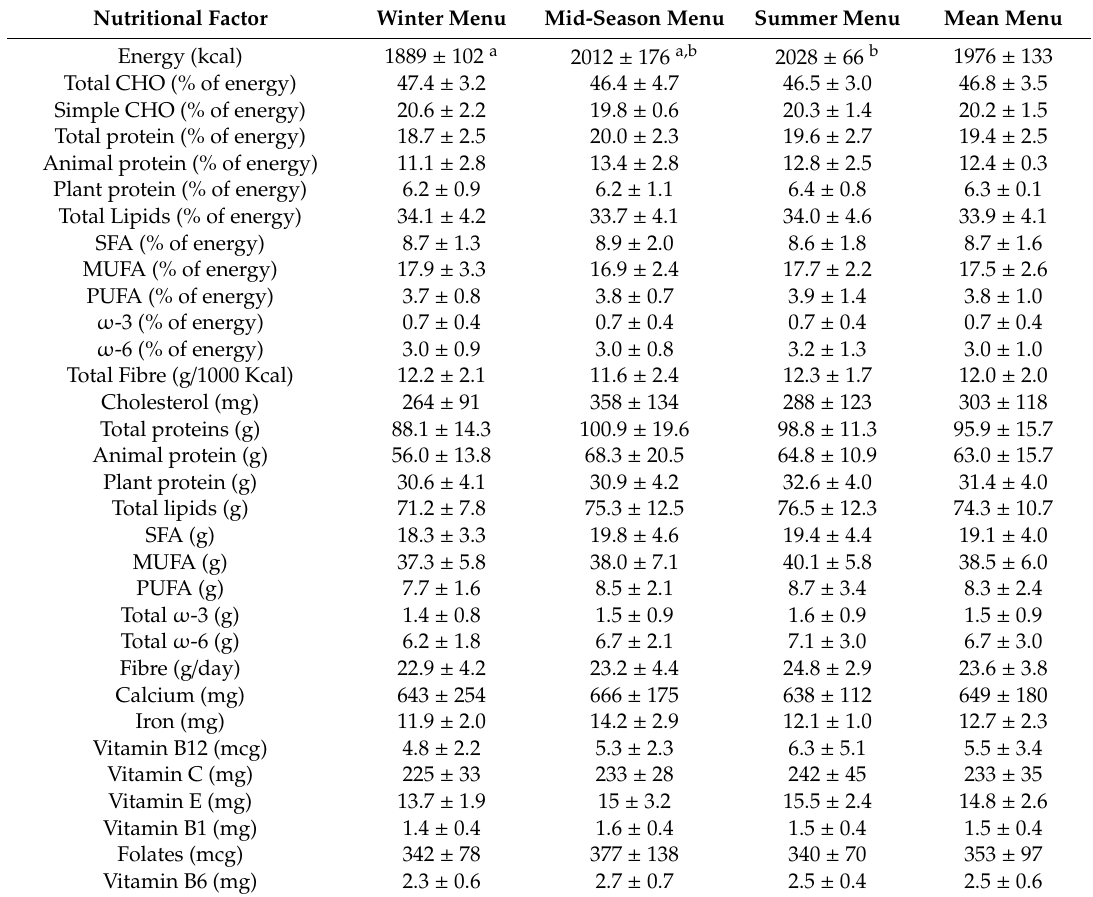
Table 2. Mean energy and nutrient composition of the nursing home menus across three seasons and overall mean